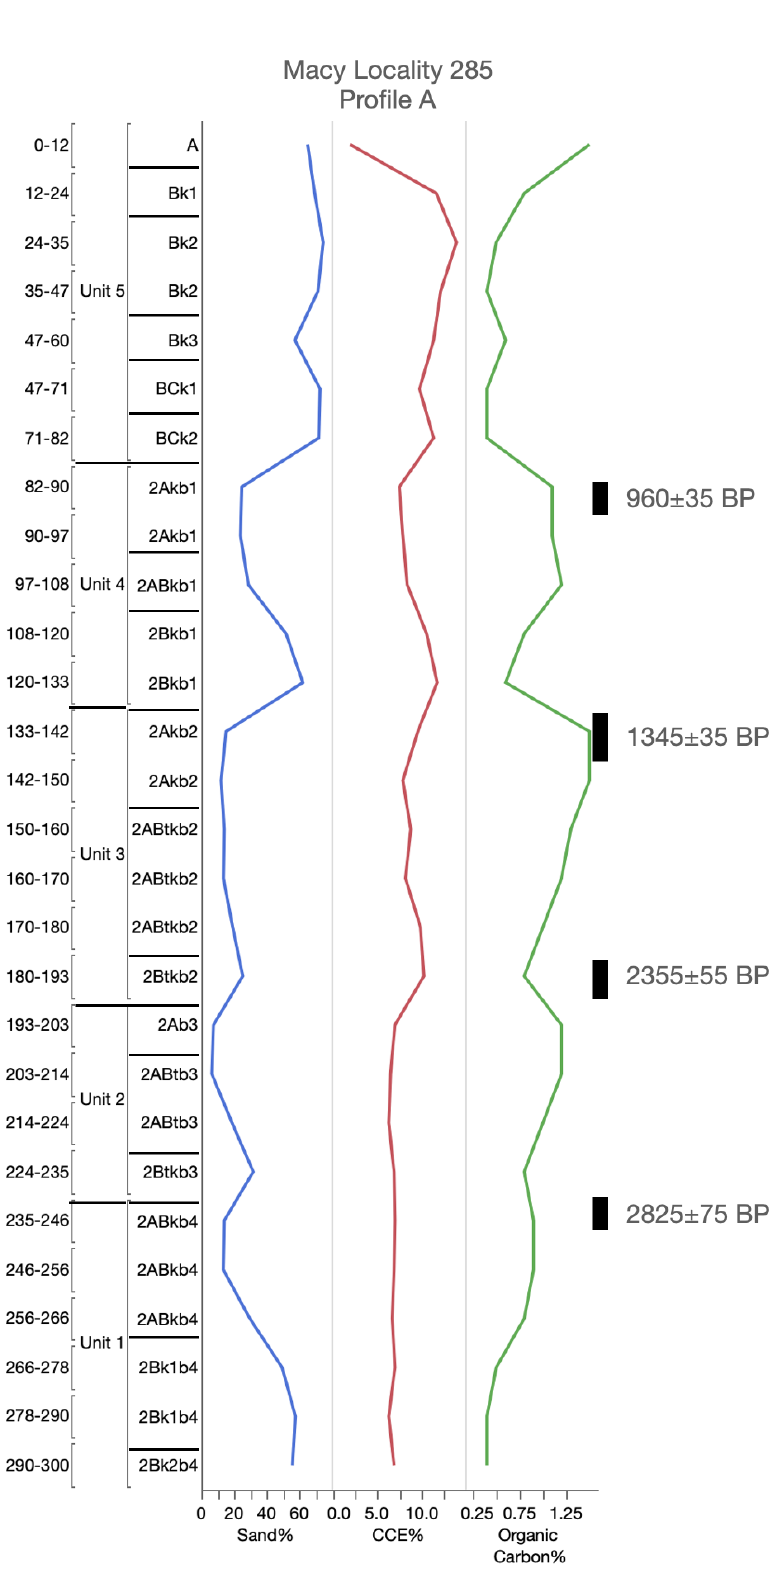
Figure A11. Accepted radiocarbon ages and soil and sediment analysis at Macy Locality 285, Profile A — Post research area, northwest, Texas. CCE = calcium carbonate equivalence.